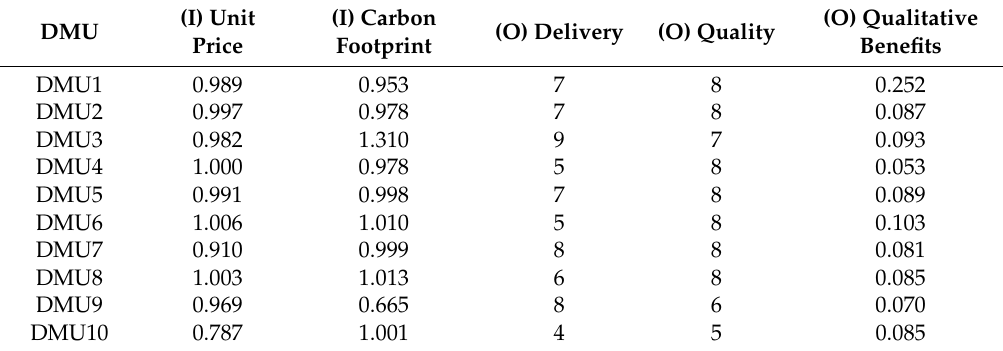
Table 5. Data used in the DEA model.